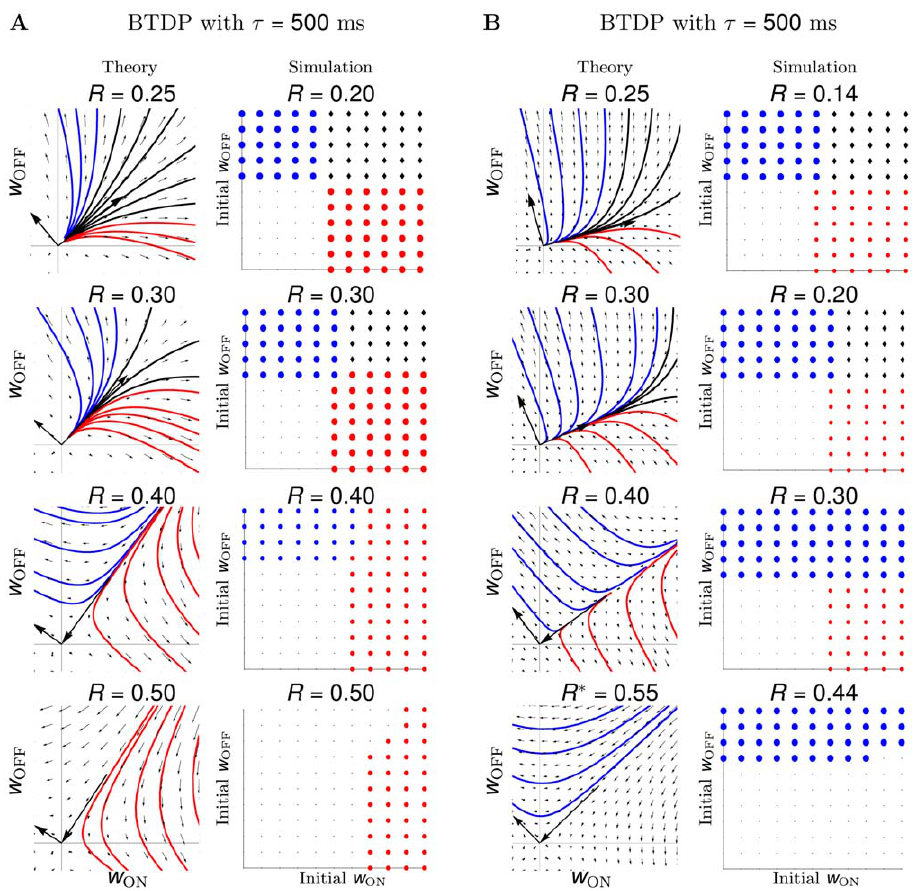
Figure 5. BTDP results in robust segregation. (A) Segregation results using BTDP for data set 1, a representative spike train recording of data sets 1–3 which have similar peaks of the pairwise input correlation for ON/ON and OFF/OFF pairs. Drawing conventions and legend as in Figure 2, and as before w max ~ 5 : 0 with discrete steps for the initial weights of 0 : 5 . As the depression-to-potentiation ratio in BTDP, R ~ I = A z , increases towards the experimentally-observed ratio, R & 0 : 42 [16], theory and simulation show the segregation of ON and OFF RGC inputs (red and blue trajectories), emerging from a state where the weights of both cell types potentiate maximally for small R (black trajectories). The region of initial conditions resulting in ON segregation is larger than the region resulting in OFF segregation, indicative of ON dominance (see main text). Similarly, unbiased initial conditions located along the main diagonal in each plot show ON segregation. (B) Segregation results using BTDP for data set 4, a representative spike train recording of data sets 4–6, which have higher OFF/OFF input correlation peaks than ON/ON peaks. As R increases, the dominant segregation outcome for a larger set of initial conditions is OFF segregation, in contrast to (A). While the match between theory and simulation is consistent for data sets 4–6 and experimentally-observed R [16], for data sets 4 and 5 a narrow range of large ratios (denoted by R (cid:2) ) resulted in OFF segregation only in simulations (bottom panels). To match predictions of the two models for this larger than experimentally-observed R , t OFF was made larger than t ON in the theoretical model (from 0.327 to 0.500, Table